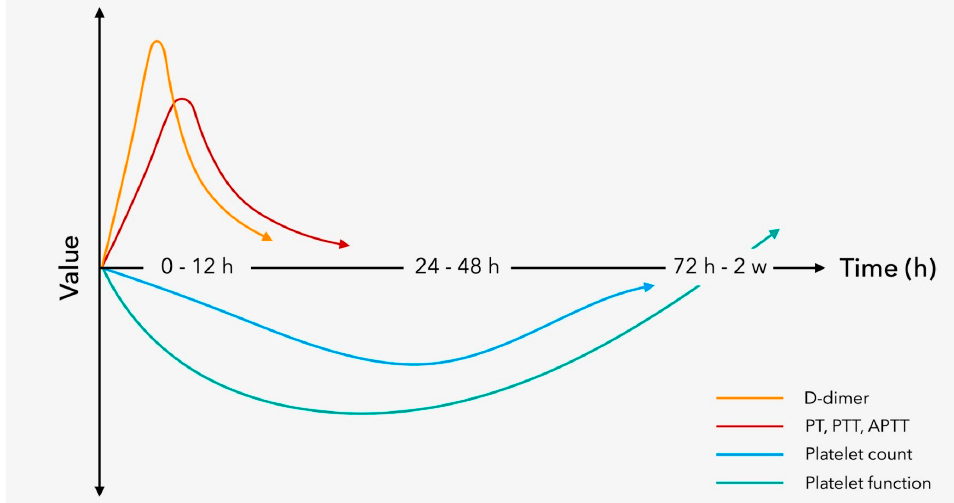
Figure 3. Conceptual timeline of hemostatic disruptions after TBI based upon changes in conven- tional coagulation assays (CCAs). Reprinted from Fletcher-Sandersjöö et al. [37], under CC BY-4.0, http://creativecommons.org/licenses/by/4.0/ (assessed on 3 January 2023)